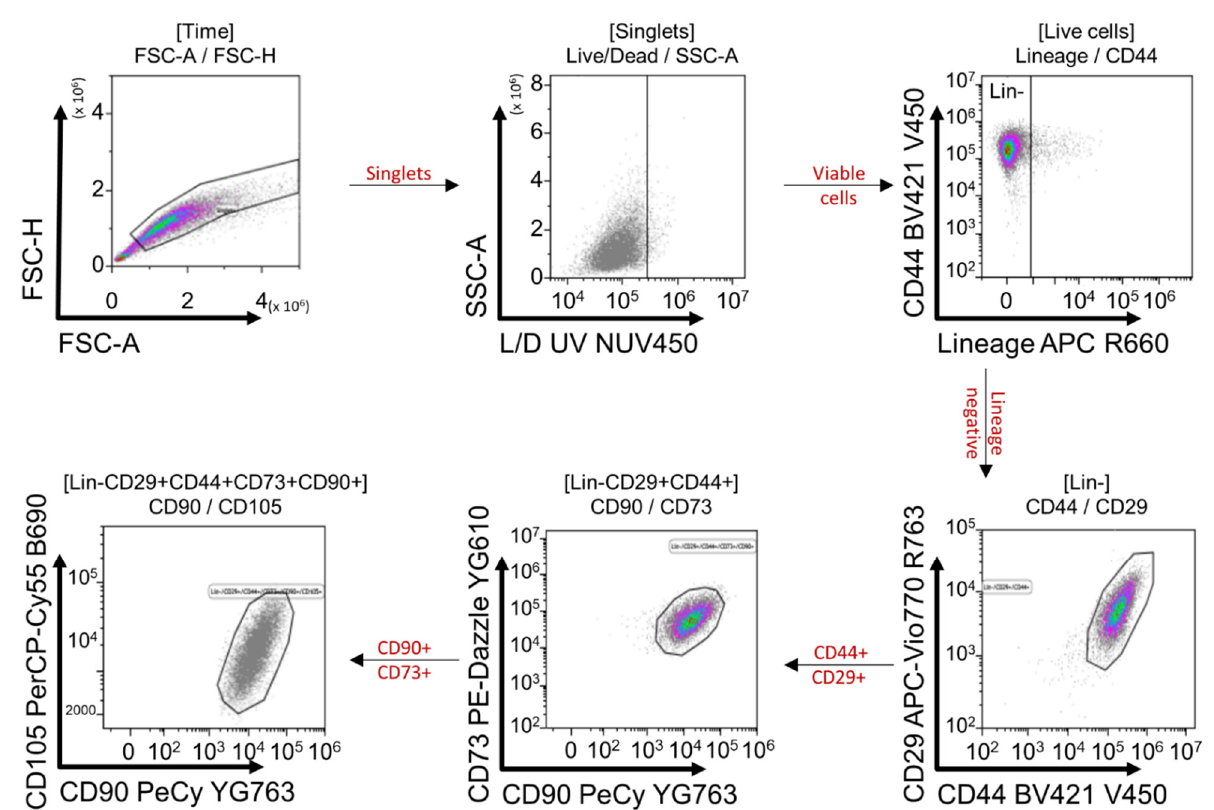
Figure A1. Gating strategy for cell surface marker profiling using LEGENDSCREEN™ Human PE Kit. Cells were prestained with a backbone panel (anti-human Lineage [Lin], anti-human CD29, CD44, CD73, CD90, CD105) and then analyzed with the LEGENDSCREEN™ human PE kit as follows: exclusion of nonsingle events (forward scatter area [FSC-A] versus forward scatter height [FSC-H]); gating of live cells (L/D versus sideward scatter area [SSC-A]); gating of all CD44+ and exclusion of all linage negative (versus anti-CD44); gating of all Lin-CD44+ and CD29+ (anti-CD29 versus anti-CD44); gating of all Lin-CD44+CD29+, CD90+ and CD73+ cells (anti-CD90 versus anti-CD73+); gating of all Lin-CD44+CD29+CD90+CD73+ and CD105+ (anti-CD90 versus anti-CD105)–the gated CD44+CD29+CD90+CD73+CD105+ BMSCs were used to further analyze individual target cell surface marker (anti-CD73 versus anti-target marker).